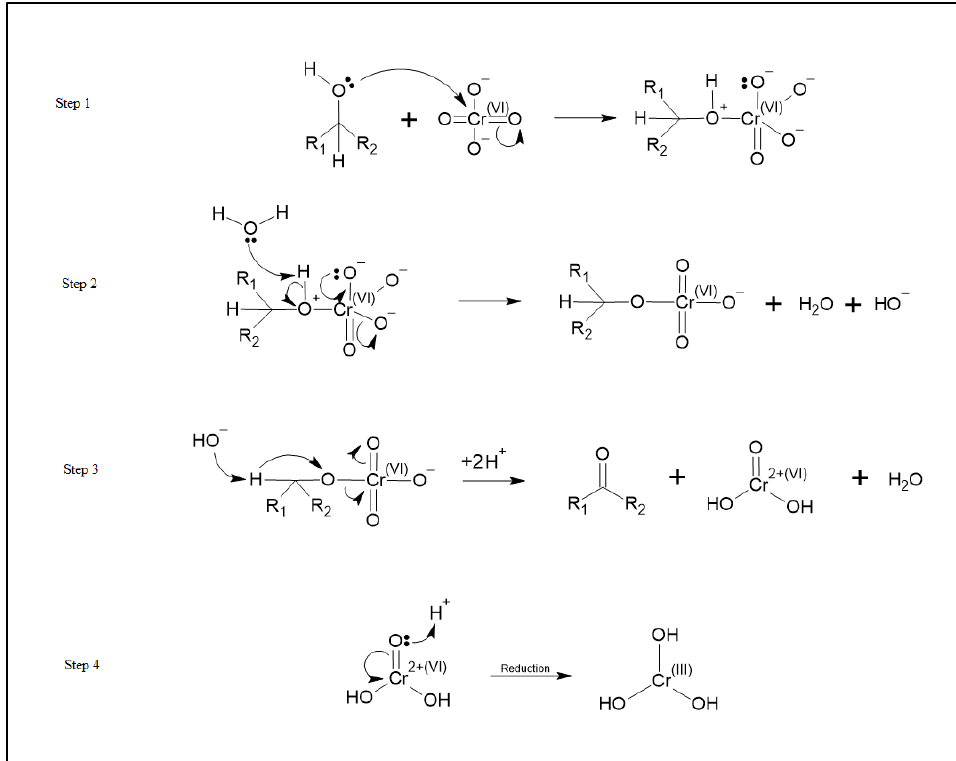
Figure 7. The adsorption schematic demonstrating the reduction of chromium (VI) in solution to chromium (III) hydroxide and the oxidation of alcohols to ketones on the activated carbon surface.